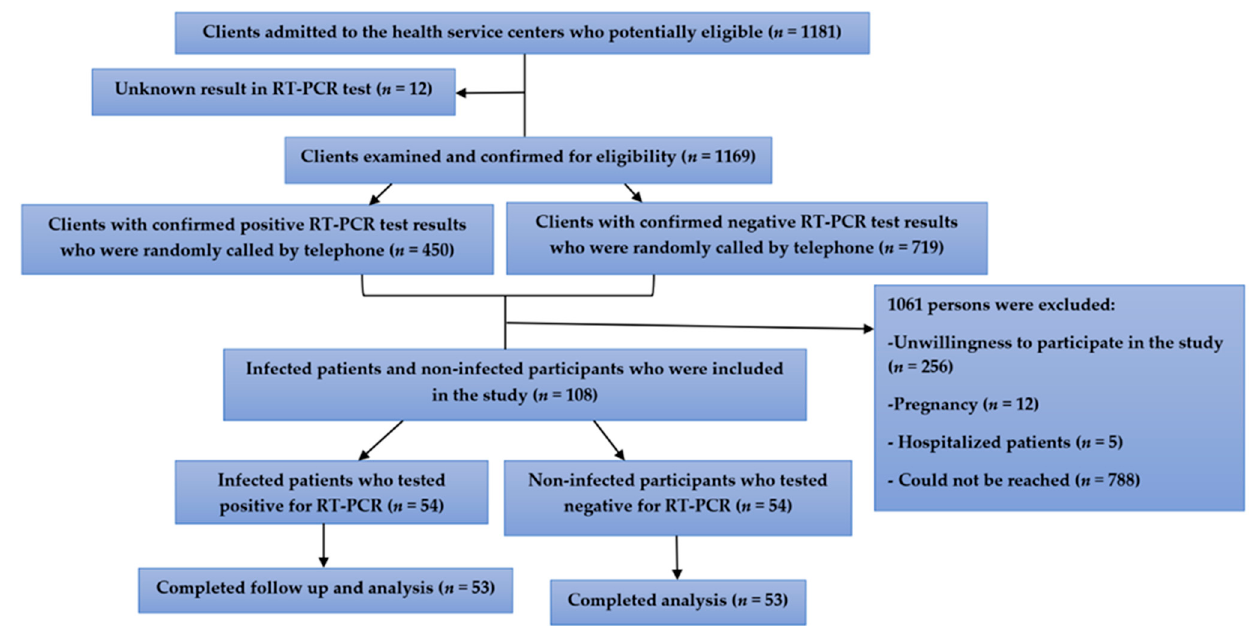
Figure 1. Flow diagram of the study